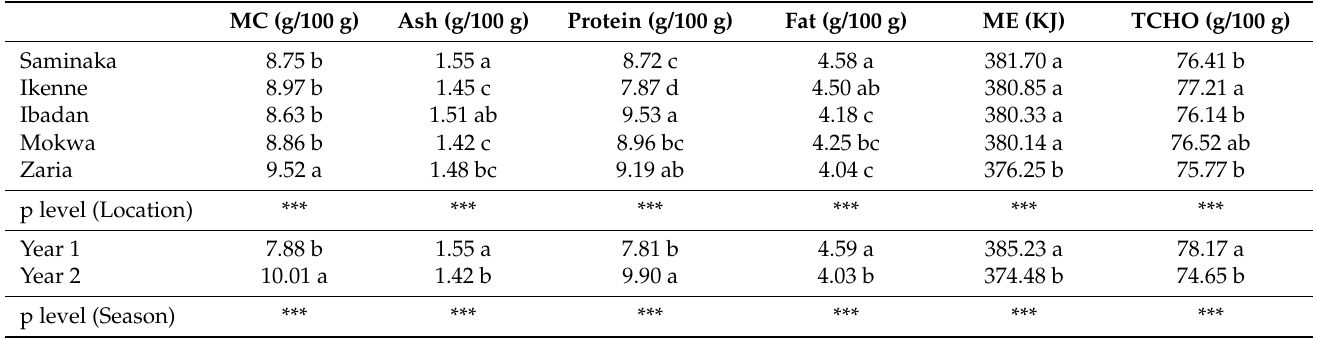
Table 3. Effects of locations and seasons on the proximate composition of maize hybrids.